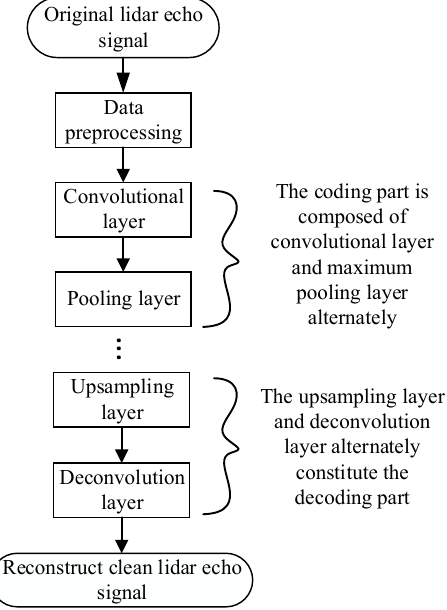
Figure 6. The block diagram of the CAENN algorithm.